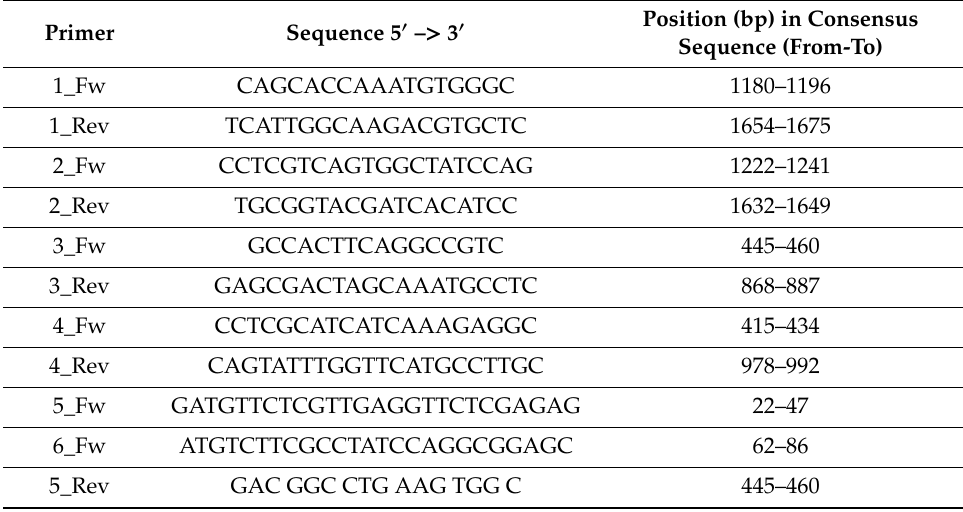
Table 2. Primers sequences, and relative coordinates in consensus sequence, used for amplification and sequencing of ALS target